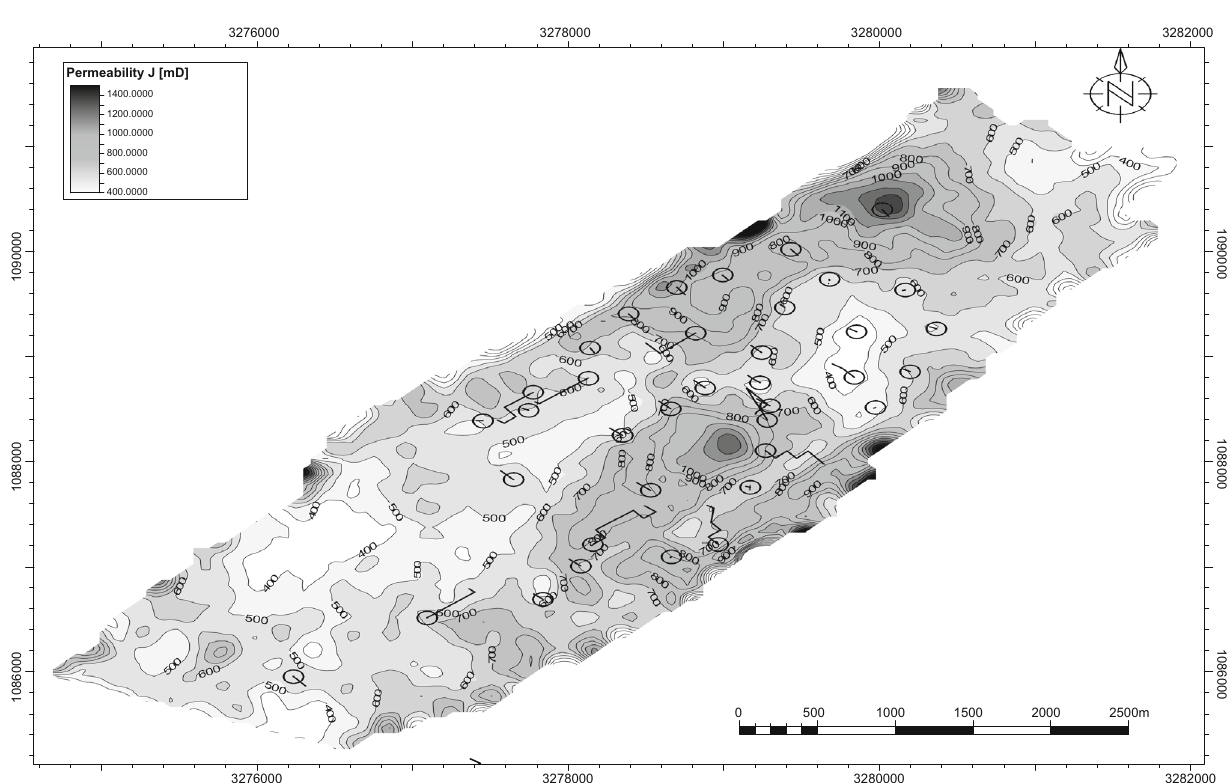
Fig. 5 Permeability distribution of the